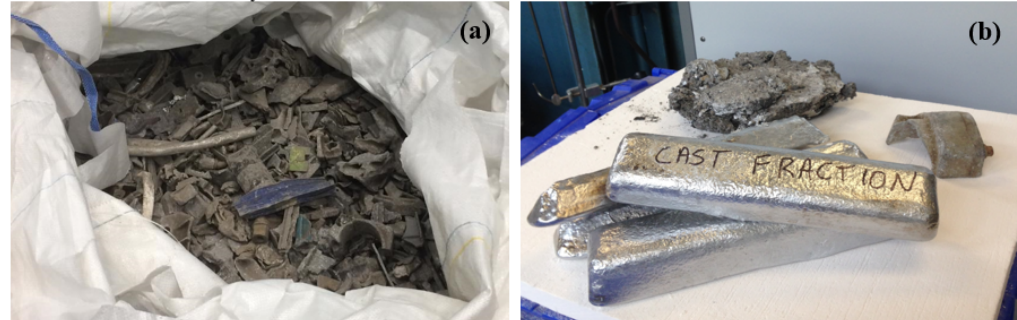
Figure 1. ( a ) As received Zorba cast fraction scrap in shredded form; ( b ) Aluminum alloy ingot and dross after remelting. Table 1. Chemical composition of the aluminum alloy recovered from Zorba cast fraction compared with some typical commercial cast alloys.